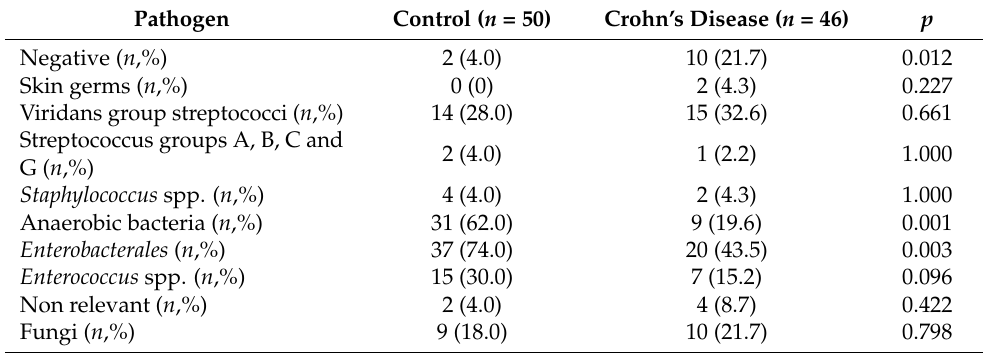
Table 2. Microbial spectrum of intra-abdominal abscesses.